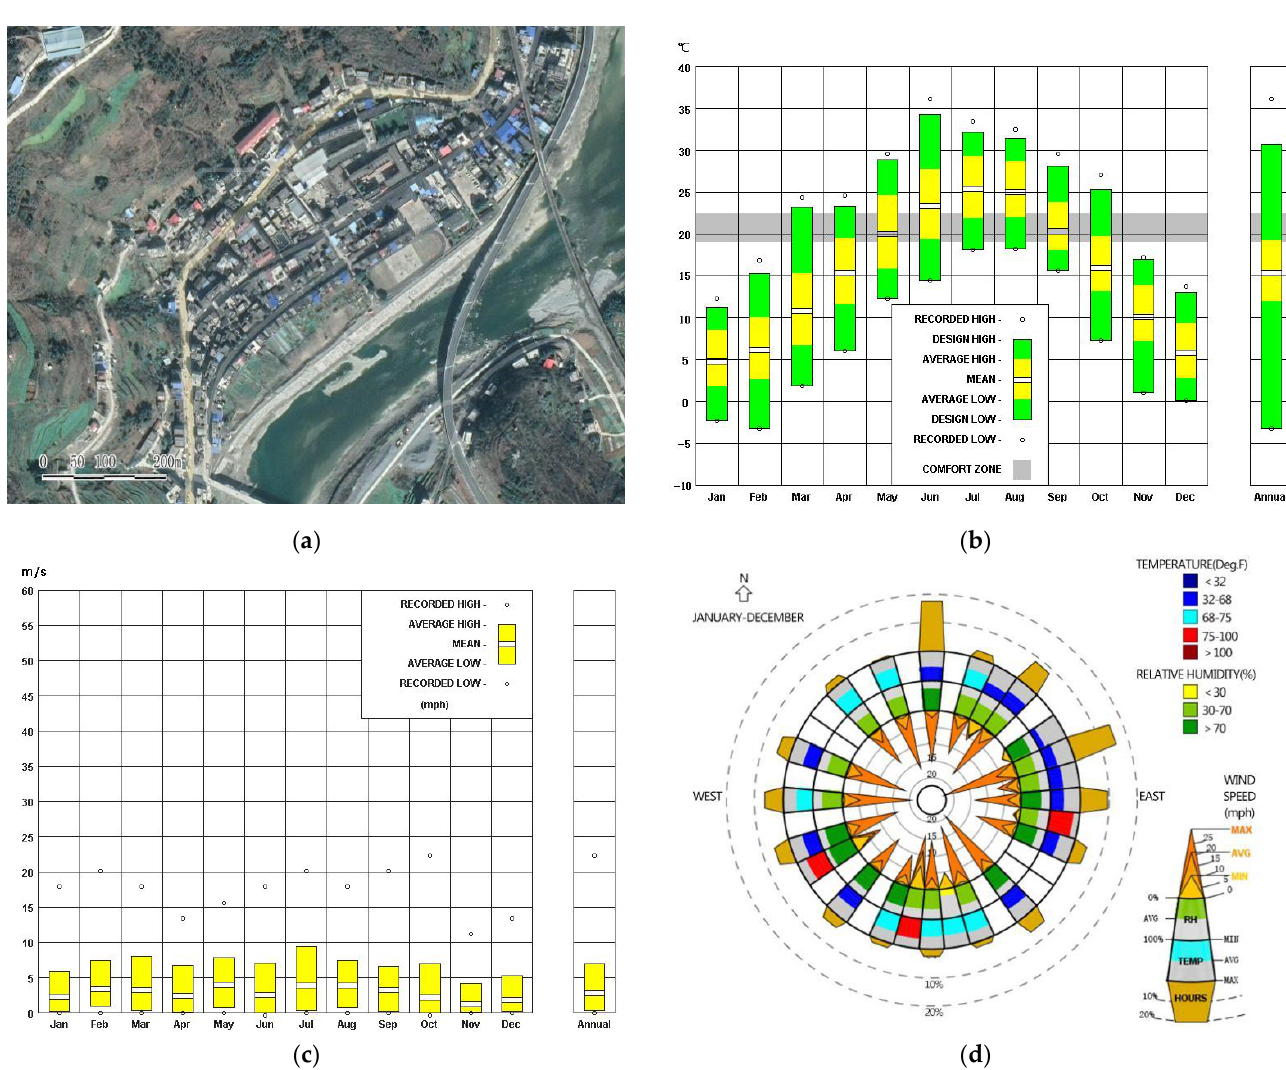
Figure 1. ( a ) Village satellite map; ( b ) Average annual temperature; ( c ) Average annual wind speed; ( d ) Temperature, humidity, and air velocity distribution throughout the year.